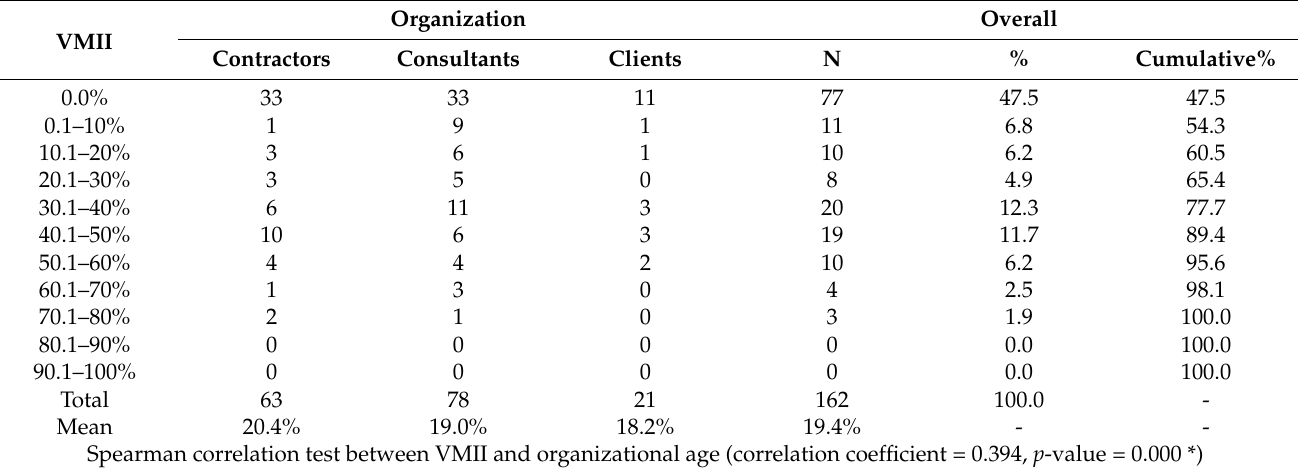
Table 2. Status of VM implementation: organization